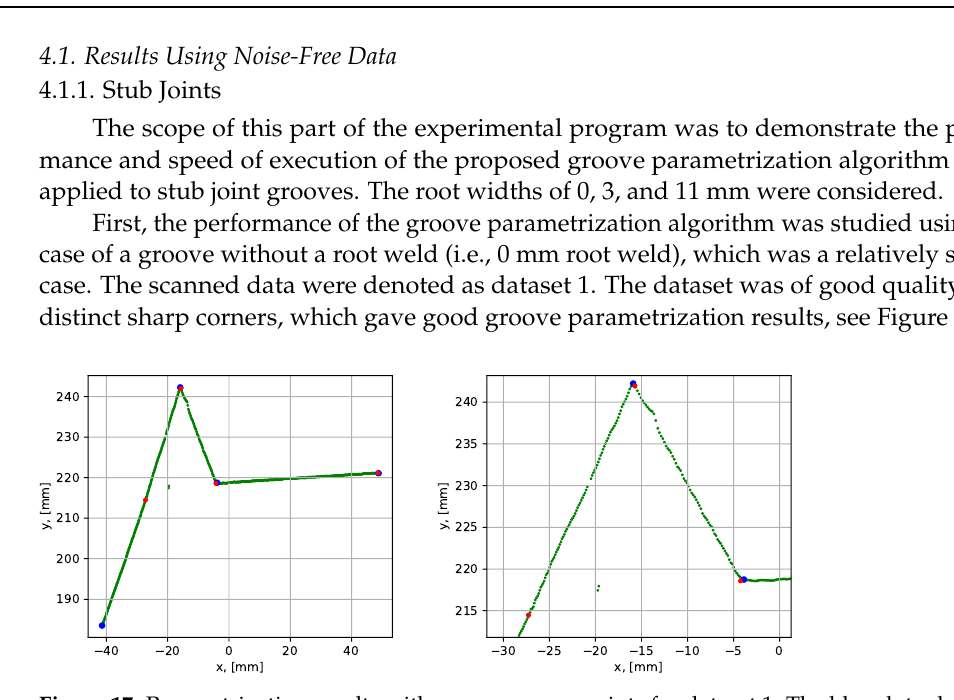
Figure 17. Parametrization results with groove corner points for dataset 1. The blue dots show the result before the iterative error elimination procedure and the red dots show after. A close-up of the graph is shown to the